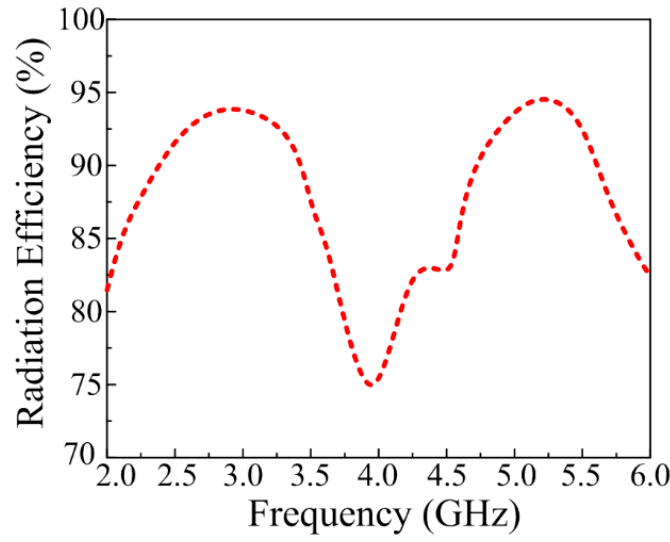
Figure 10. Estimated radiation efficiency of the proposed work.